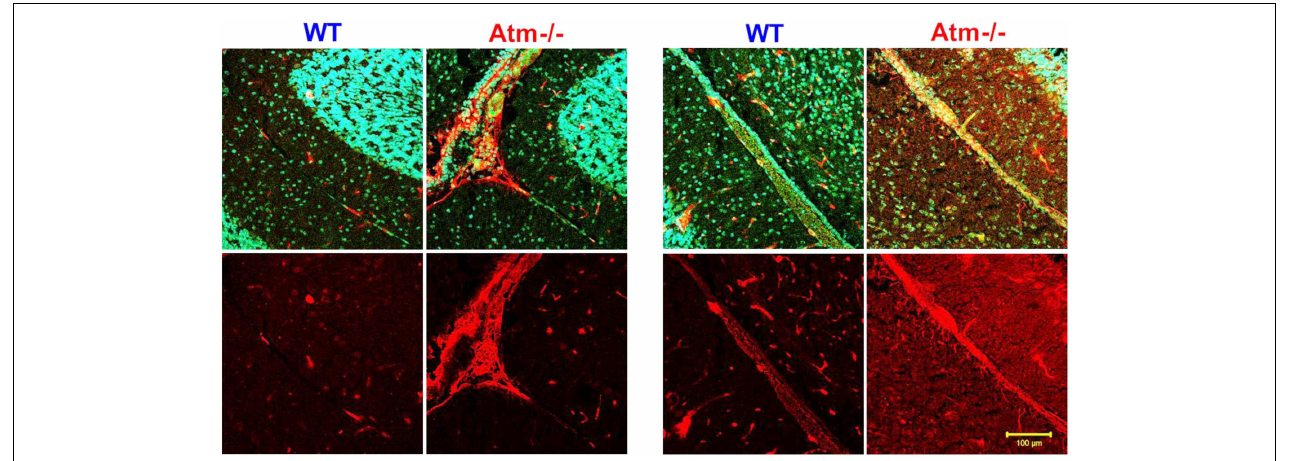
(stained with the pan-endothelial marker CD3, green) of Atm − / − mice compared to the labeling inWT controls. Cell nuclei are stained with Sytox Blue (blue).